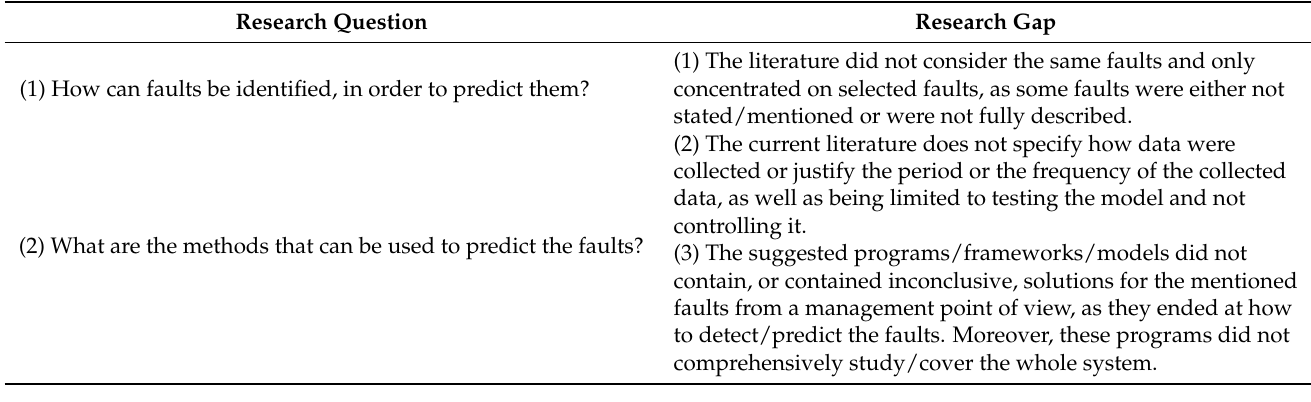
Table 1. Research Questions and Gaps.